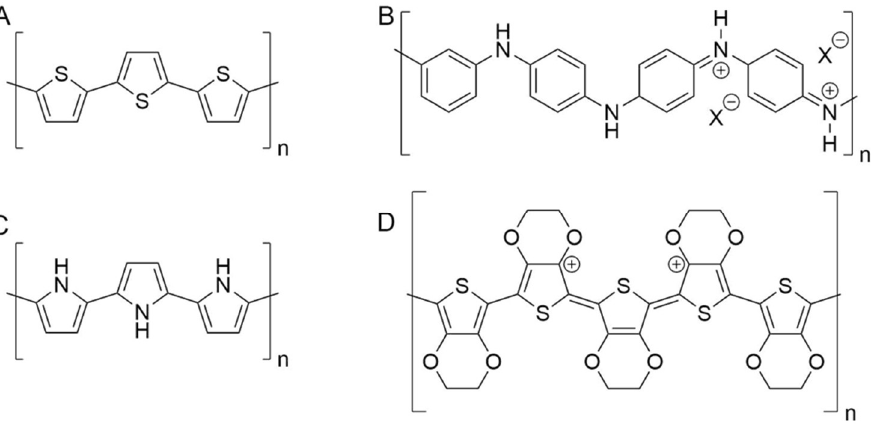
Figure 2. Chemical structure of the main conductive polymers (CPs) employed in textile sensors. ( A ) Polythiophene; ( B ) polyaniline; ( C ) polypyrrole; ( D ) poly (3,4-ethylendioxythiopene).